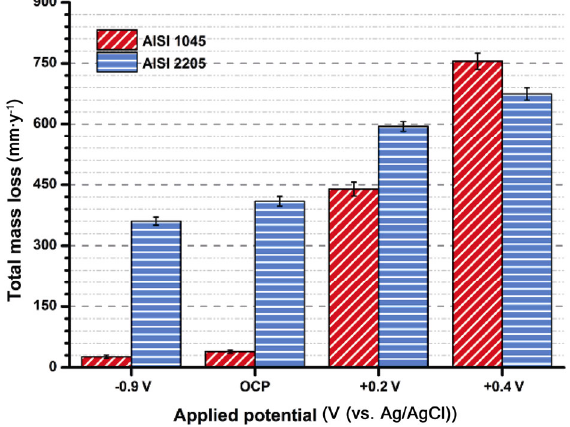
Fig. 11 The total mass loss of AISI 1045 and AISI 2205 at different applied potentials after sliding under 80 N load and 80 rpm